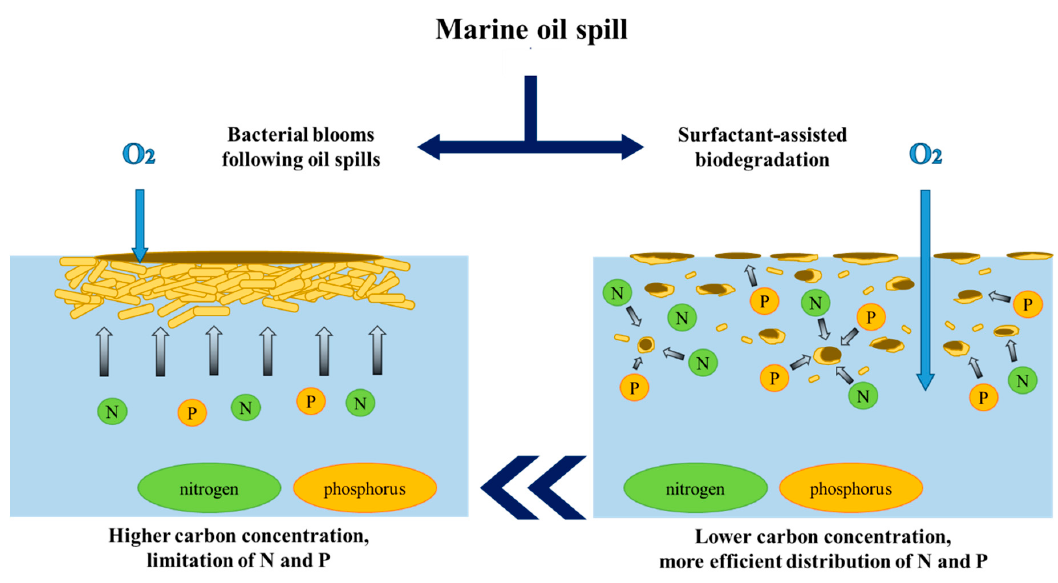
Figure 6. Distribution of nutrients (nitrogen, phosphorous, etc.) during marine oil spills in cases of bacterial blooms ( left ) and after applications of surfactants ( right ).